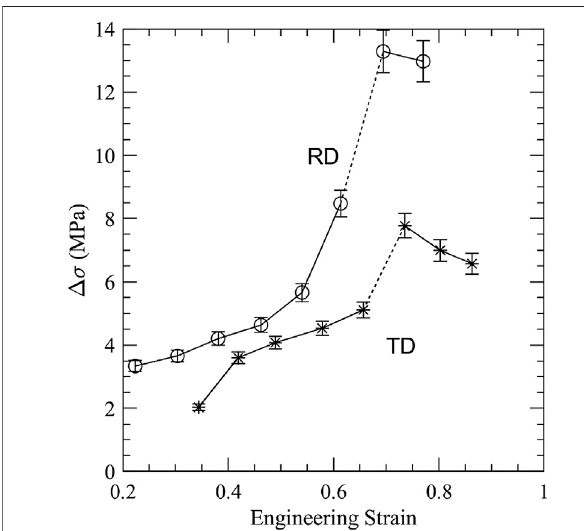
FIGURE 3 | Change in yielding ( Δ σ ) after an isothermal 2 h hold at room temperature of a 304 stainless steel in the rolling direction and transverse directionduringinterruptedtensiletestsperformedatroomtemperatureanda strain rate of 0.001 s − 1 . The maximum seen at a strain of ∼ 0.7 strain corresponds to an extended isothermal hold at room temperature.